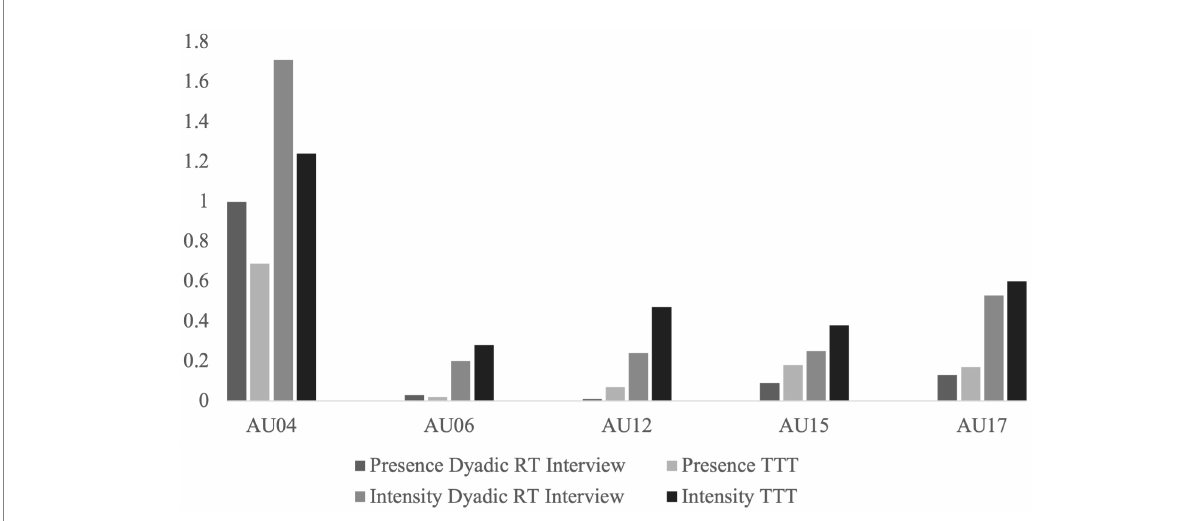
FIGURE 5 Descriptive statistics of the behavior measures for Angela. Mean of action unit (AU) presence and intensity for Angela across two contexts: dyadic reminiscence therapy (RT) interview, and technology-driven group reminiscence therapy (TTT). The orange and green columns represent the RT context, and the yellow and brown columns represent the TTT context. The presence of the AUs represents the percentage of time the AU was present from 0 (not present) to 1 (always present). The intensity of the AUs represents the intensity of the AU movement on a continuous scale from 0 (min) to 5